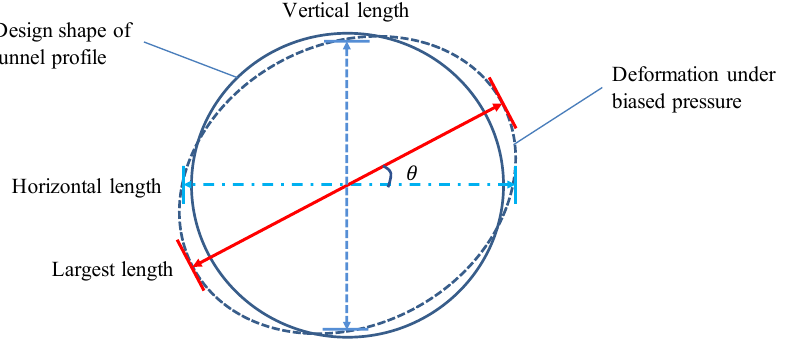
Figure 15. The assumed cross-sectional profile of a deformed metro